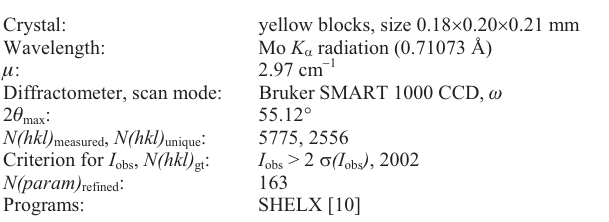
Table 1. Data collection and handling.